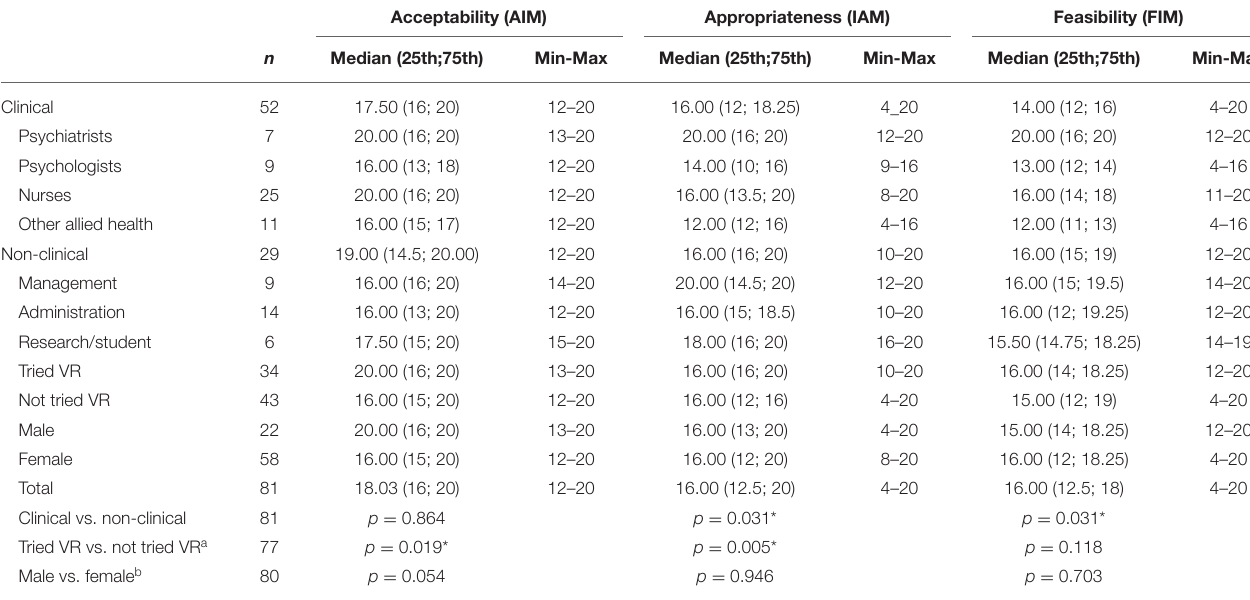
TABLE 4 | Descriptive statistics and group comparisons on IAM, AIM, and